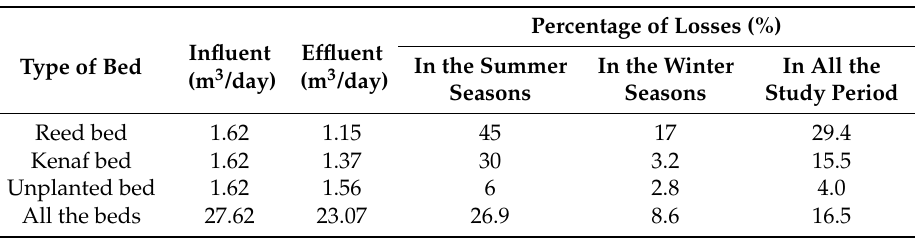
Table 1. Mean daily influent and effluent flow rates for each